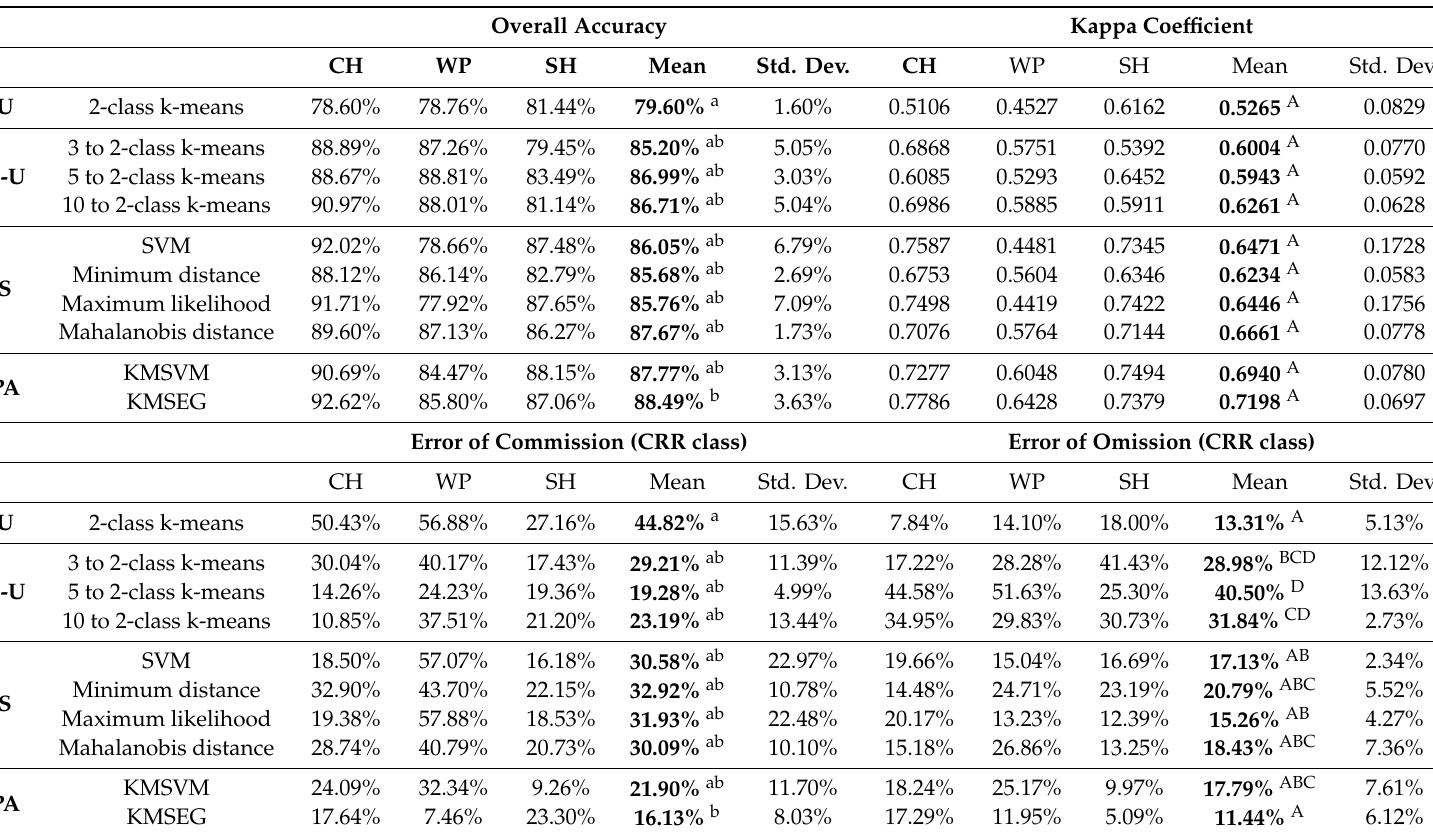
Table 3. The summarized results of accuracy comparison between unsupervised, combined-unsupervised, supervised classifications, and proposed automatic regional classifications. Three cotton fields were used to evaluate the methods of classification between healthy and cotton root rot (CRR) infested field